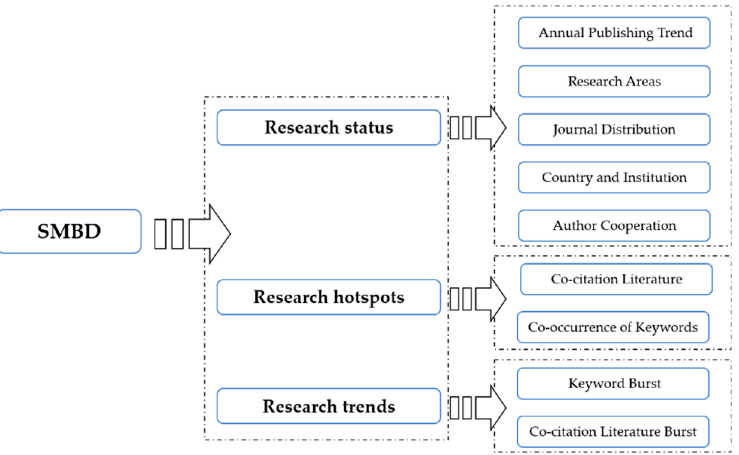
Figure 1. Research framework.